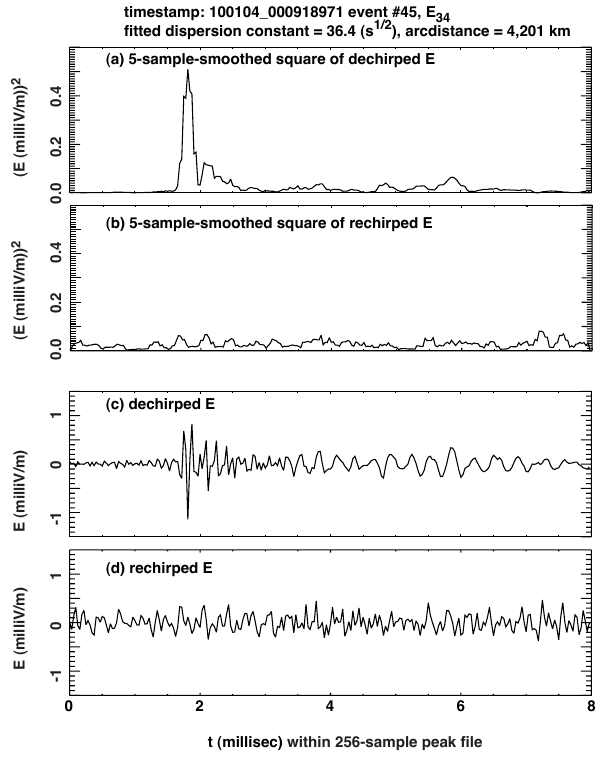
Fig. 3. Time series for the 45th peak (the first above in Fig. 2d). There are 256 samples for this peak in the distilled peak archive. (a) Smoothed square of electric field vs. time for the dechirped peak. (b) Smoothed square of electric field after rechirping via DFFT on these 256 samples of electric field. (c) Dechirped elec- tric field. (d) Rechirped electric